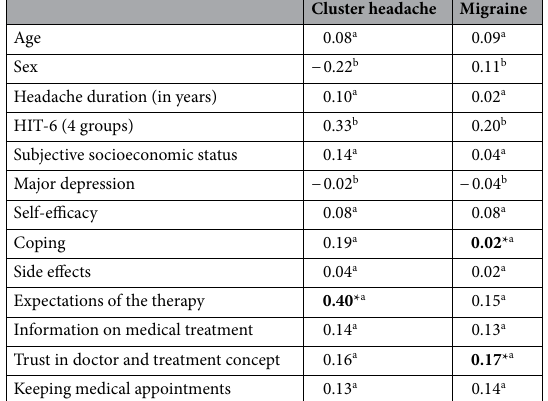
Table 7. Correlation coefficient r between adherence (yes/no) and sociodemographic and headache-related factors, differentiated by type of headache; * p ≤ 0.05; ** p ≤ 0.01; *** p ≤ 0.001. a Eta-coefficient, b Phi-coefficient. Significant values are in